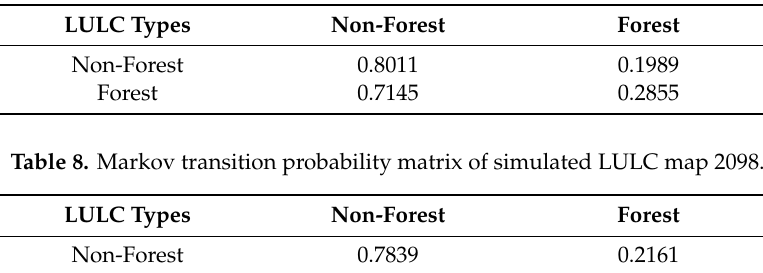
Table 7. Markov transition probability matrix of simulated LULC map 2058.